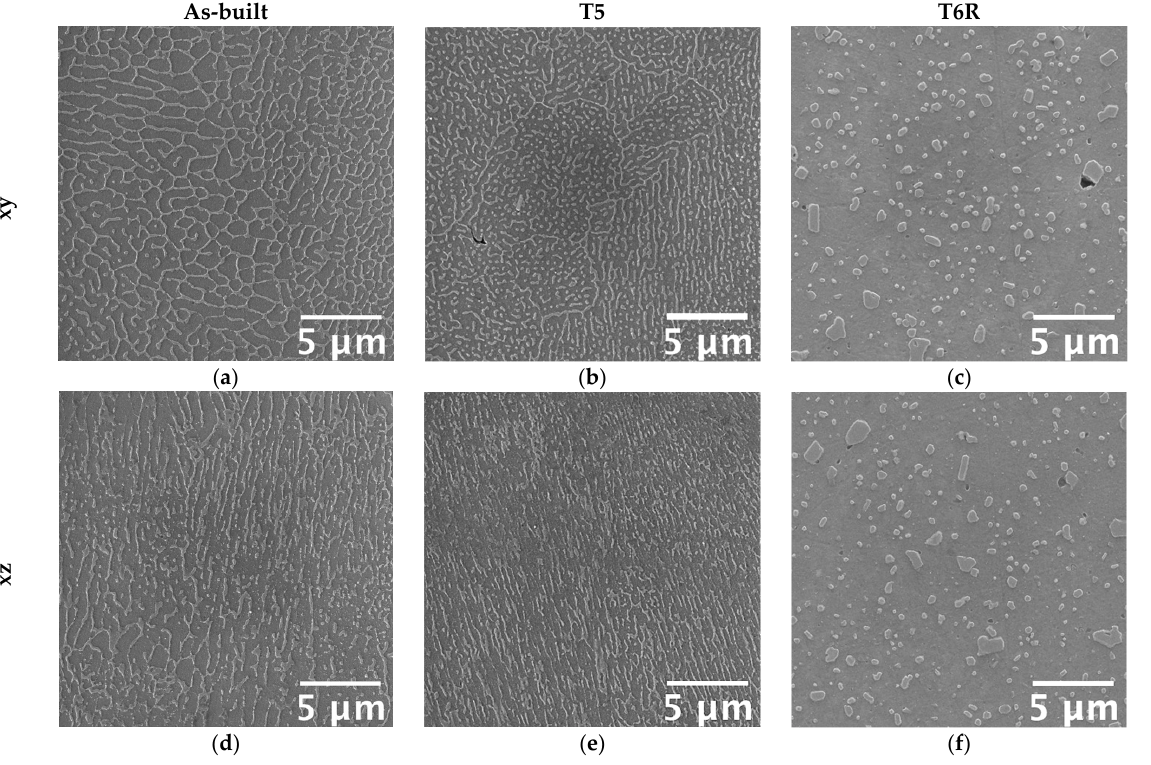
Figure 12. FEG-SEM high magnification micrographs showing the typical microstructure of the as- built, T5, and T6R AlSi7Mg PBF-LB alloy after tensile tests performed at high temperature (200 °C): ( a – c ) along the direction parallel to the building platform (xy plane); ( d – f ) along the direction parallel to the building one (xz plane).